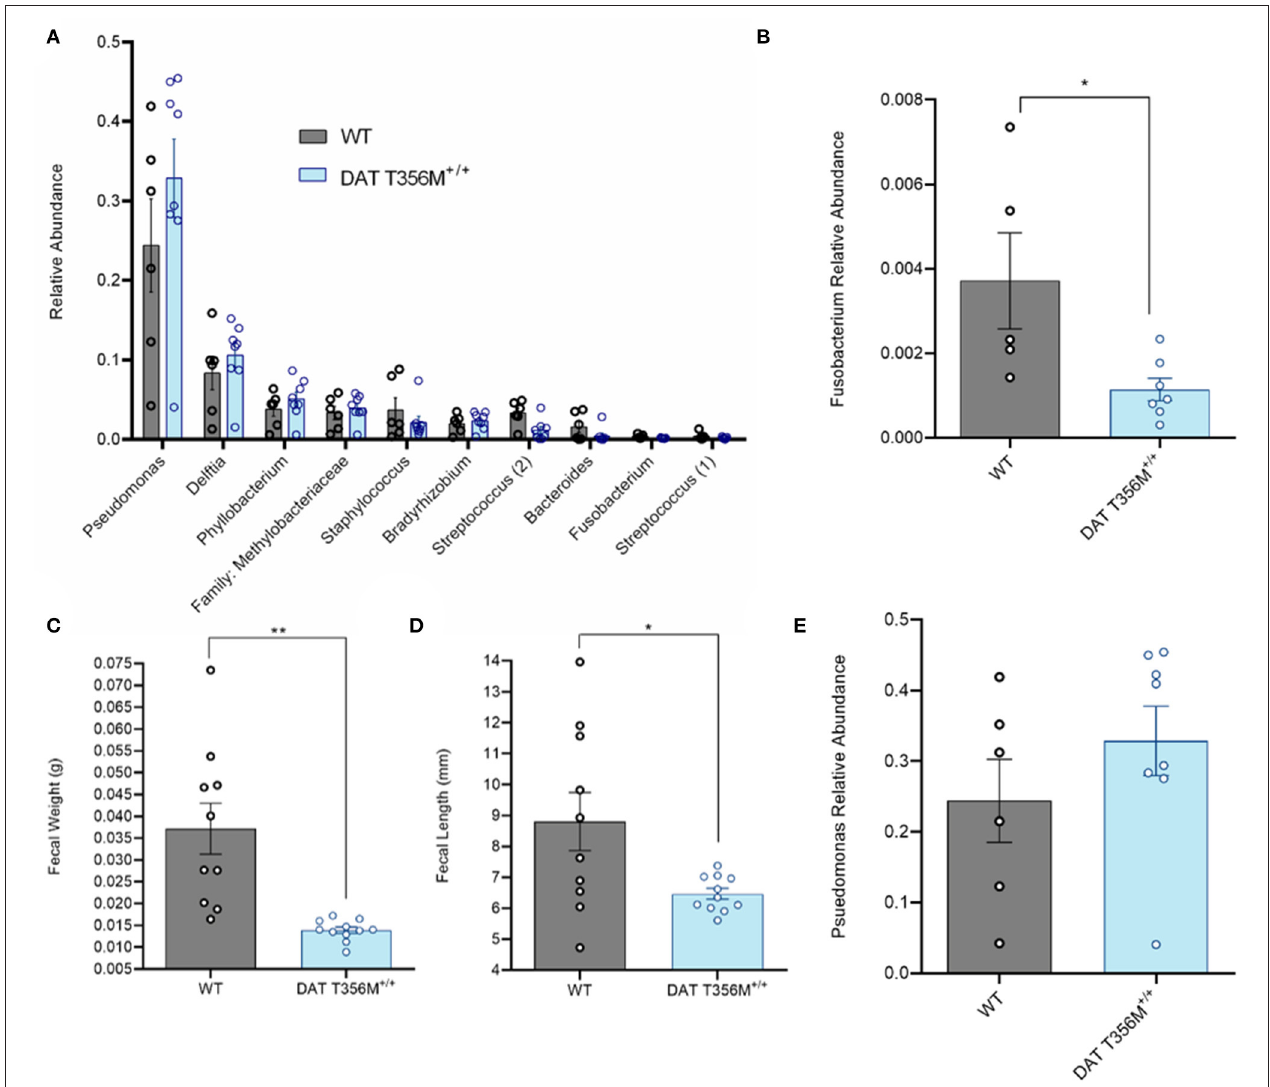
FIGURE 3 | DAT T356M + / + mice have altered oral microbiota. (A) Relative abundance of top 10 OTUs isolated from oral swabs from WT and DAT T356M + / + mice. (B) DAT T356M + / + mice have significantly lower abundance of oral Fusobacterium compared to WT mice (WT = 0.003716 ± 0.001136 relative units, DAT T356M + / + = 0.001 ± 0.0003 relative units; n = 5 WT, 7 DAT T356M + / + ; t = 2.589, df = 10, * = p = 0.027 by Student’s t -test). (C) DAT T356M + / + mice have significantly decreased fecal weight compared to WT mice (WT = 0.0371 ± 0.0058g, DAT T356M + / + = 0.0138 ± 0.0139g; n = 10 fecal pellets from 3 WT mice, 11 fecal pellets from 4 DAT T356M + / + mice; t = 3.981, df = 9, ** = p = 0.0032 by Welch’s t -test). (D) DAT T356M + / + mice have significantly decreased fecal length compared to WT mice (WT = 8.805 ± 0.9381mm, DAT T356M + / + = 6.469 ± 0.1727mm; n = 10 feces from 3 WT mice, 11 feces from 4 DAT T356M + / + mice; t = 2.449, df =